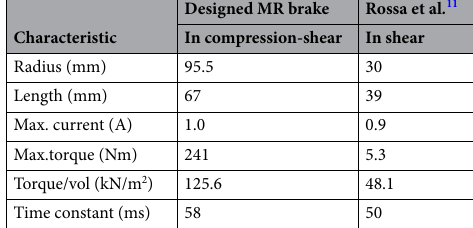
Table 3. Specifications of the proposed MR brake and comparison to conventional MR